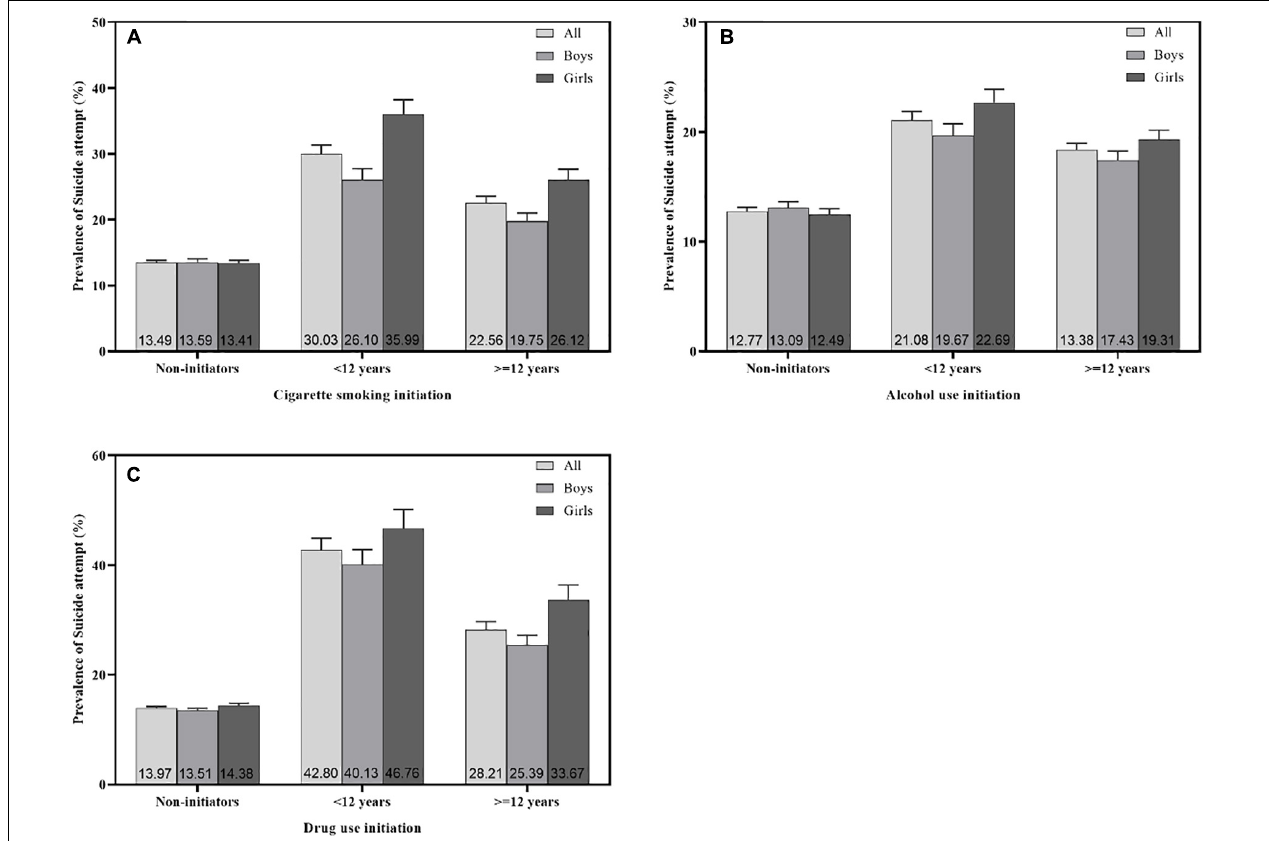
FIGURE 2 | Prevalence (%) of attempted suicide by initiation of substance use, namely (A) cigarette smoking, (B) alcohol use, and (C) other drug use, among in-school African adolescents. Bars denote standard